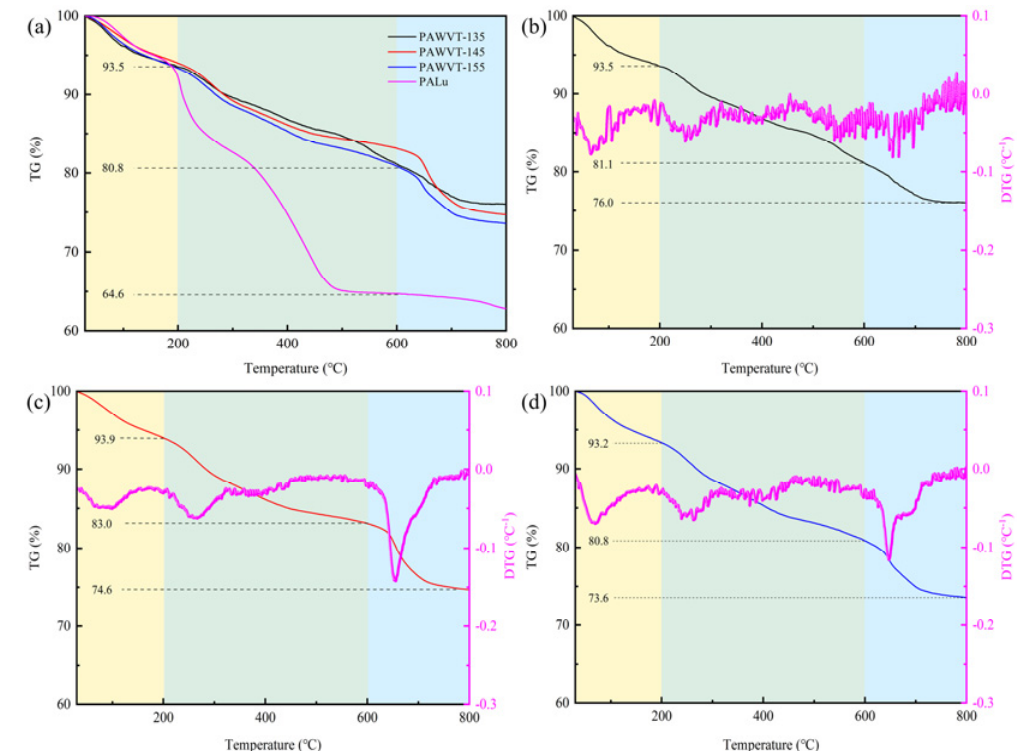
Fig. 3 (a) TG curves of the samples and TG–derivative thermogravimetry (DTG) curves of (b) PAWVT-135, (c) PAWVT-145, and (d) PAWVT-155.